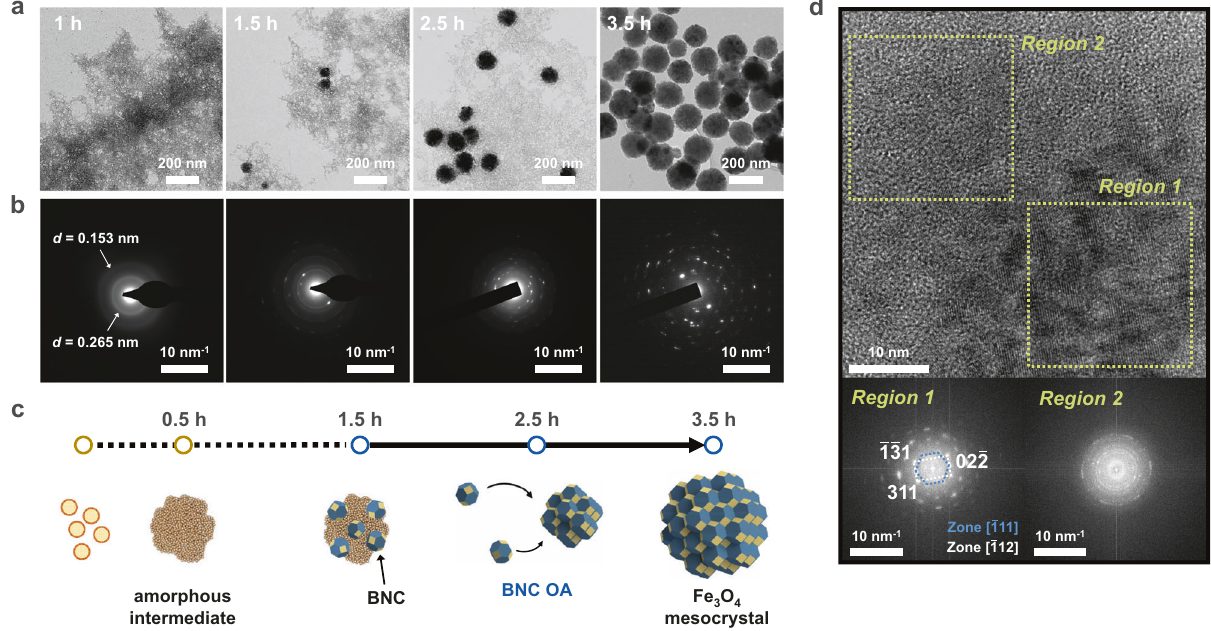
Fig. 1 Control of Fe 3 O 4 mesocrystal crystallisation pathway via OA. a TEM images and b SAED patterns of Fe oxyhydroxide intermediates and Fe 3 O 4 mesocrystals at different reaction times. c Crystallisation pathway of Fe 3 O 4 mesocrystals including stepwise transformation (dotted line) and OA (solid line). d HR-TEM image at the boundary between crystalline Fe 3 O 4 (Region 1) and the poorly crystalline Fe oxyhydroxide intermediate phase (Region 2) and corresponding FFT